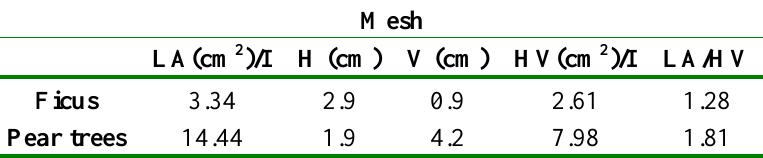
Table 3. Summary of the results obtained in the laboratory tests ( Ficus ) and in the field tests with pear trees. LA: leaf area. I: Impact. H, V: horizontal and vertical dimensions of a mesh grid in the mid-plane of the vegetation at the height of the LIDAR. HV = H ×